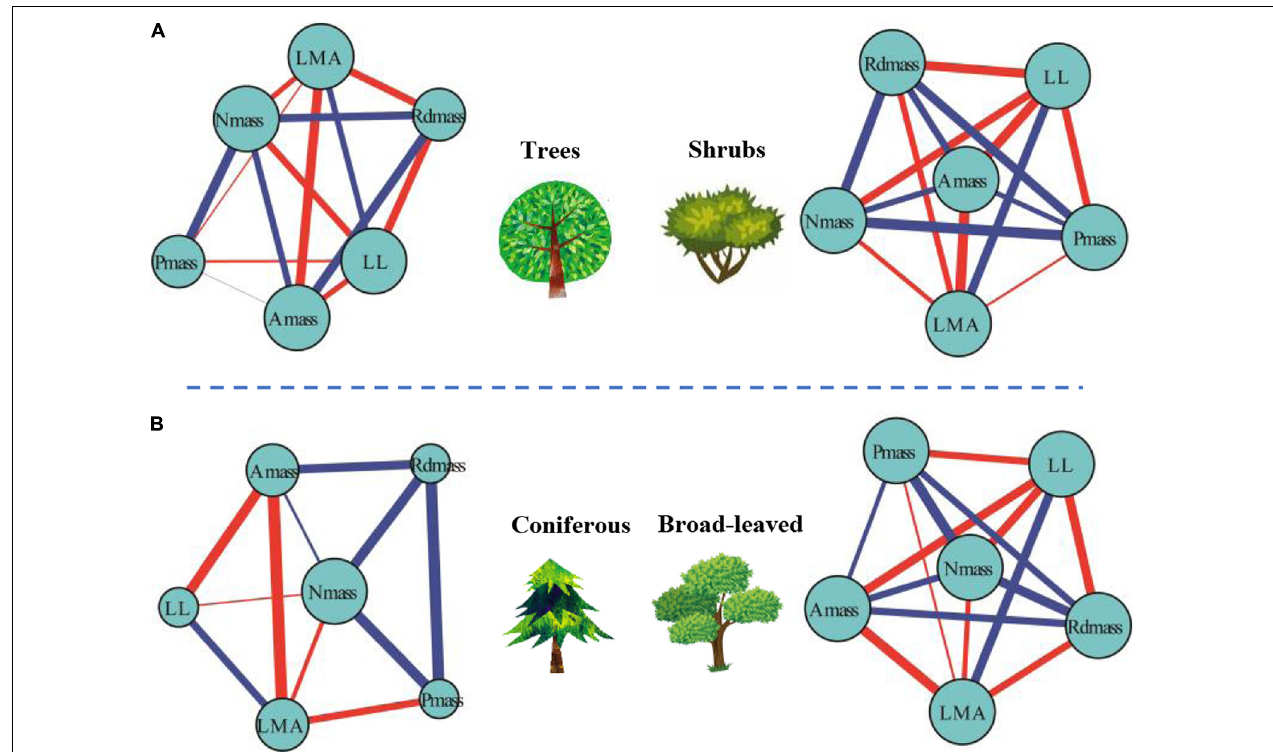
FIGURE 4 | Differences of leaf traits networks (LTNs) in different plant growth forms (A) and plant life forms (B) based on global data. Red and blue edges show negative and positive correlations, respectively. The correlation strength among traits is shown by line thickness. The node size is shown as